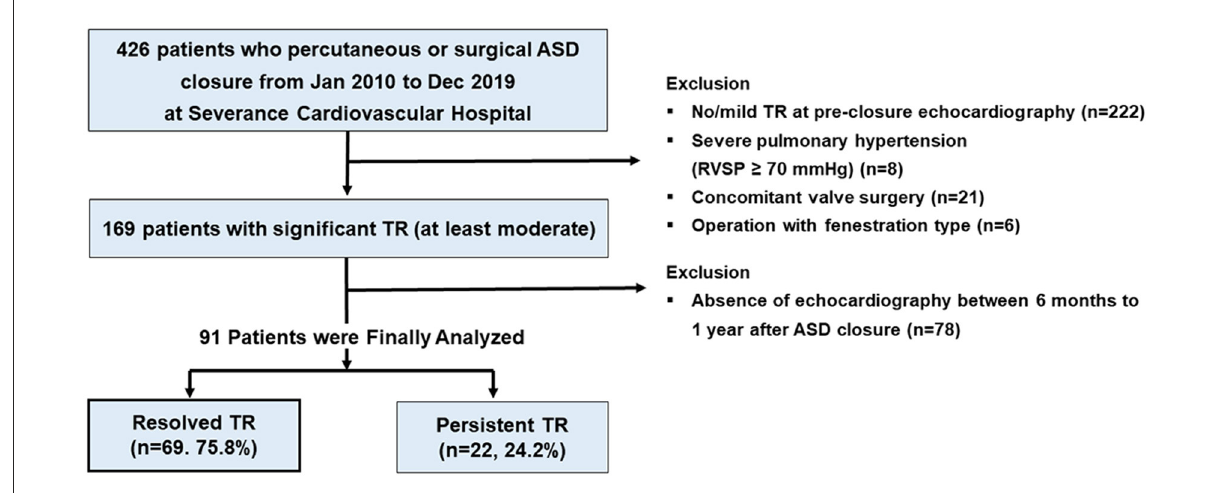
FIGURE1 Graphical representation of the patient selection